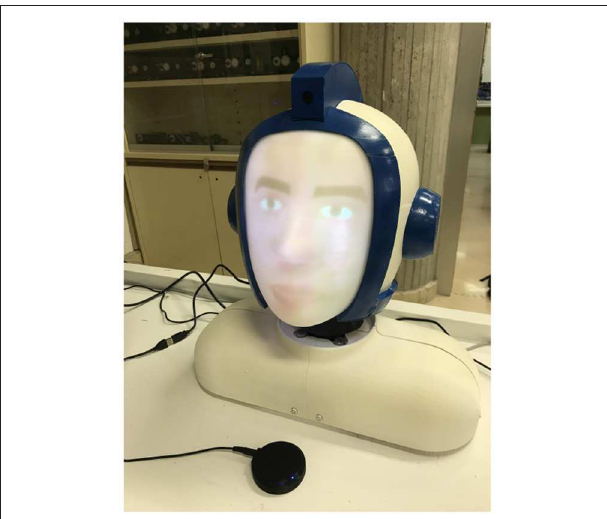
FIGURE 8 | Robotic head